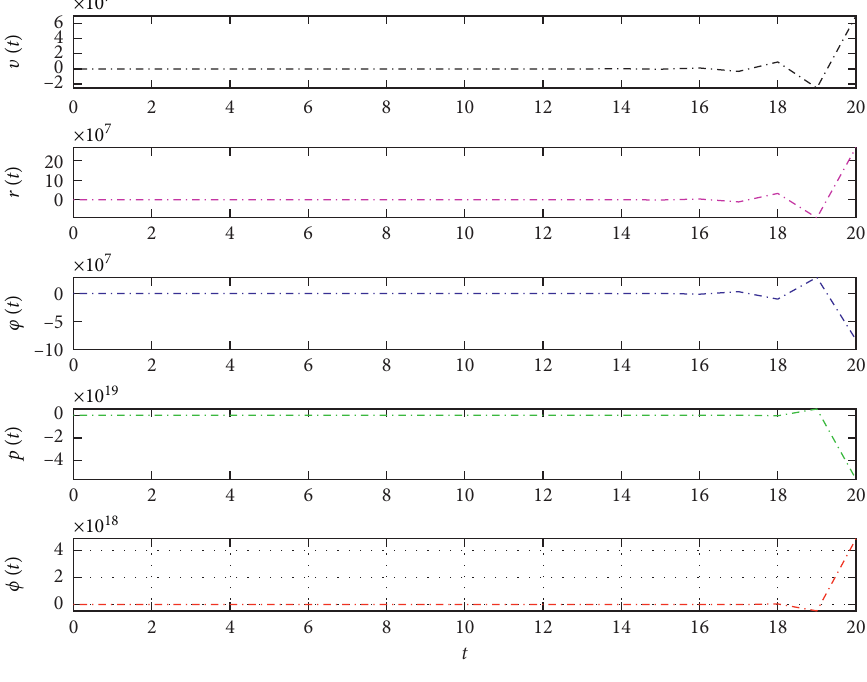
Figure 7: The state response of open-loop NSUSVs (25).